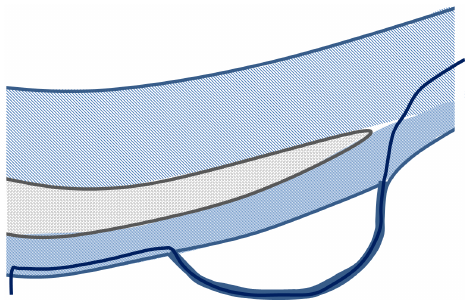
Figure 4. Overview over the study reach of the Urbach. The wider spaced blue shading represents the main channel, the tighter shading the side channel, and the full blue colour the drainage ditch. The grey-shaded area delineates the in-stream island between the main and side channel, the dark blue line the approximate position of the fibre-optic